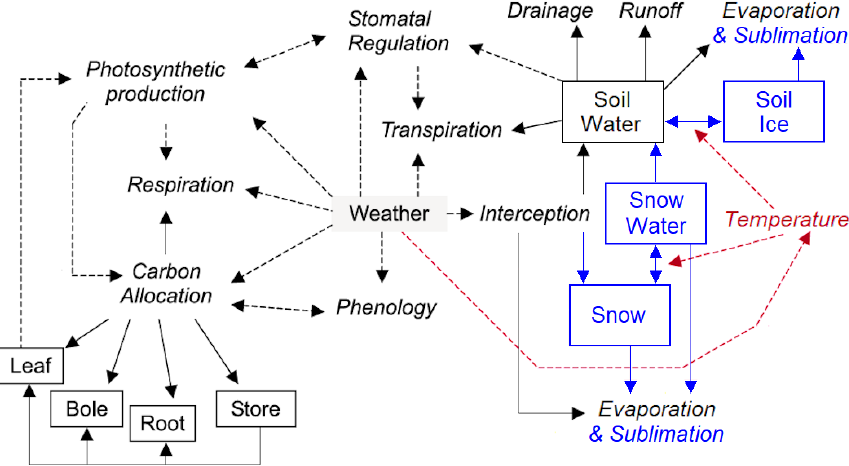
Figure 1. Diagram showing the main features in the new version of MAIDENiso, with old components and fluxes in black and new ones in blue for snow/ice and in red for the thermal module. Processes are in italics, boxes are carbon and water pools, broken lines are links between processes, and solid lines are carbon and water fluxes. Figure was modified from Misson (2004).